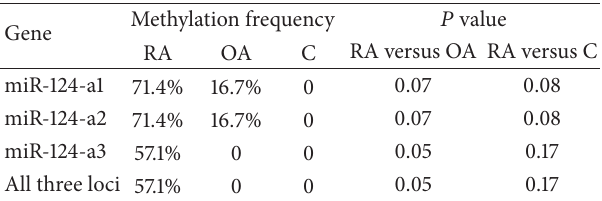
Table 2: Methylation status of miR-124a in synovial tissues of RA and OA ∗